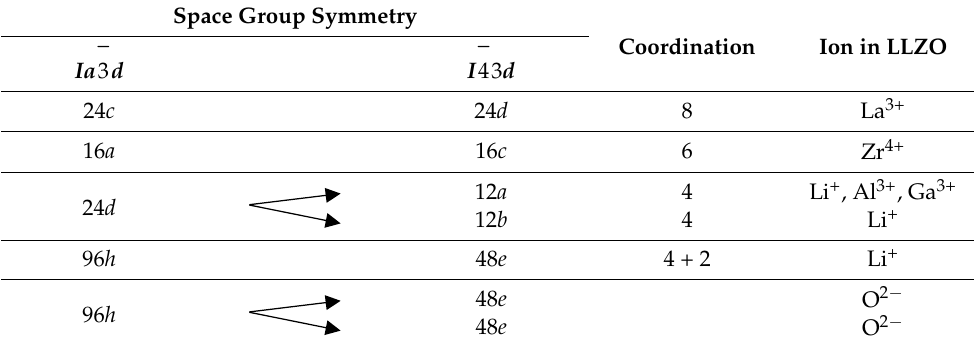
Table 1. Comparison of crystallographic positions in garnets with typical Ia 3 d [19] and acentric I 43 d symmetry.